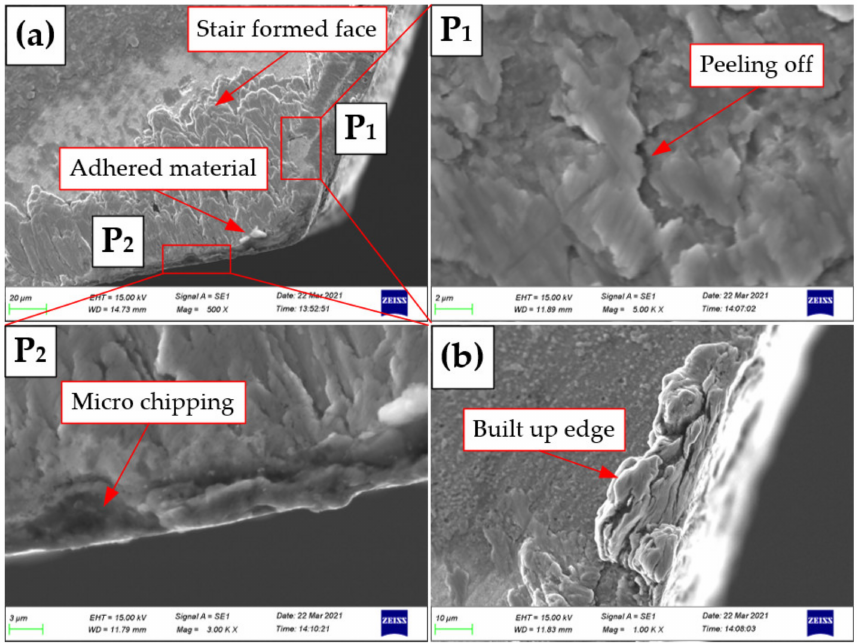
Figure 4. Tool wear morphologies (SEM): ( a ) Tool A, P 1 and P 2 are partially enlarged views of the rake face on Tool A; ( b ) Tool B.